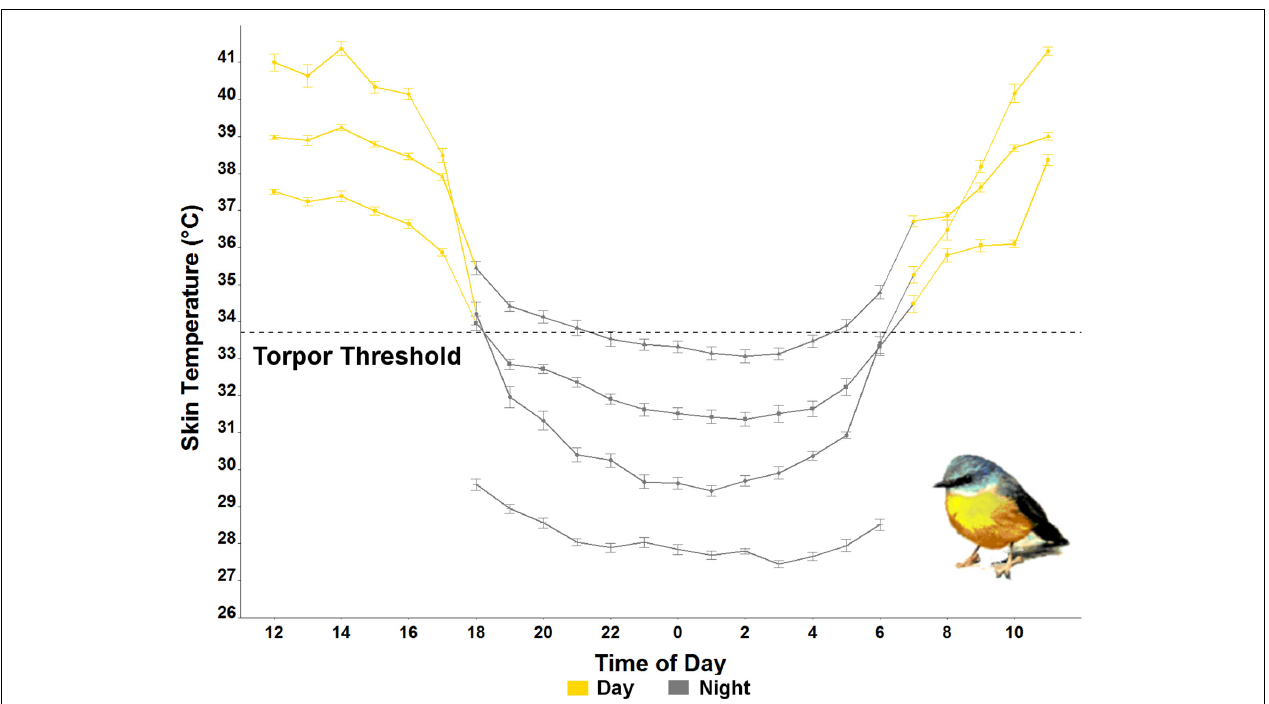
FIGURE 2 | Average hourly skin temperature (T s ) ± standard error of the four individual eastern yellow-robins measured in July in the wild in NSW, Australia (2020). The torpor threshold (black dashed line at 33.7 ◦ C) was calculated as 5 ◦ C below the resting T s